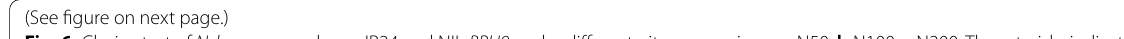
(See figure on next page.) Fig. 6 Choice test of N. lugens nymphs on IR24 and NIL‑ BPH9 under different nitrogen regimes. a N50. b N100. c N200. The asterisks indicate differences between IR24 and NIL‑ BPH9 as * p < 0.05; ** p < 0.01; *** p < 0.001; ns no